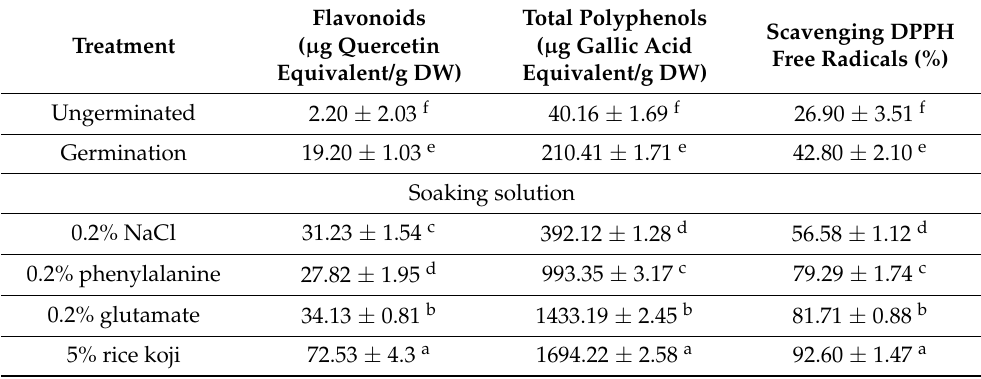
Table 2. Antioxidant active components and DPPH free radical-scavenging ability analysis of different soaking solutions on sprouted